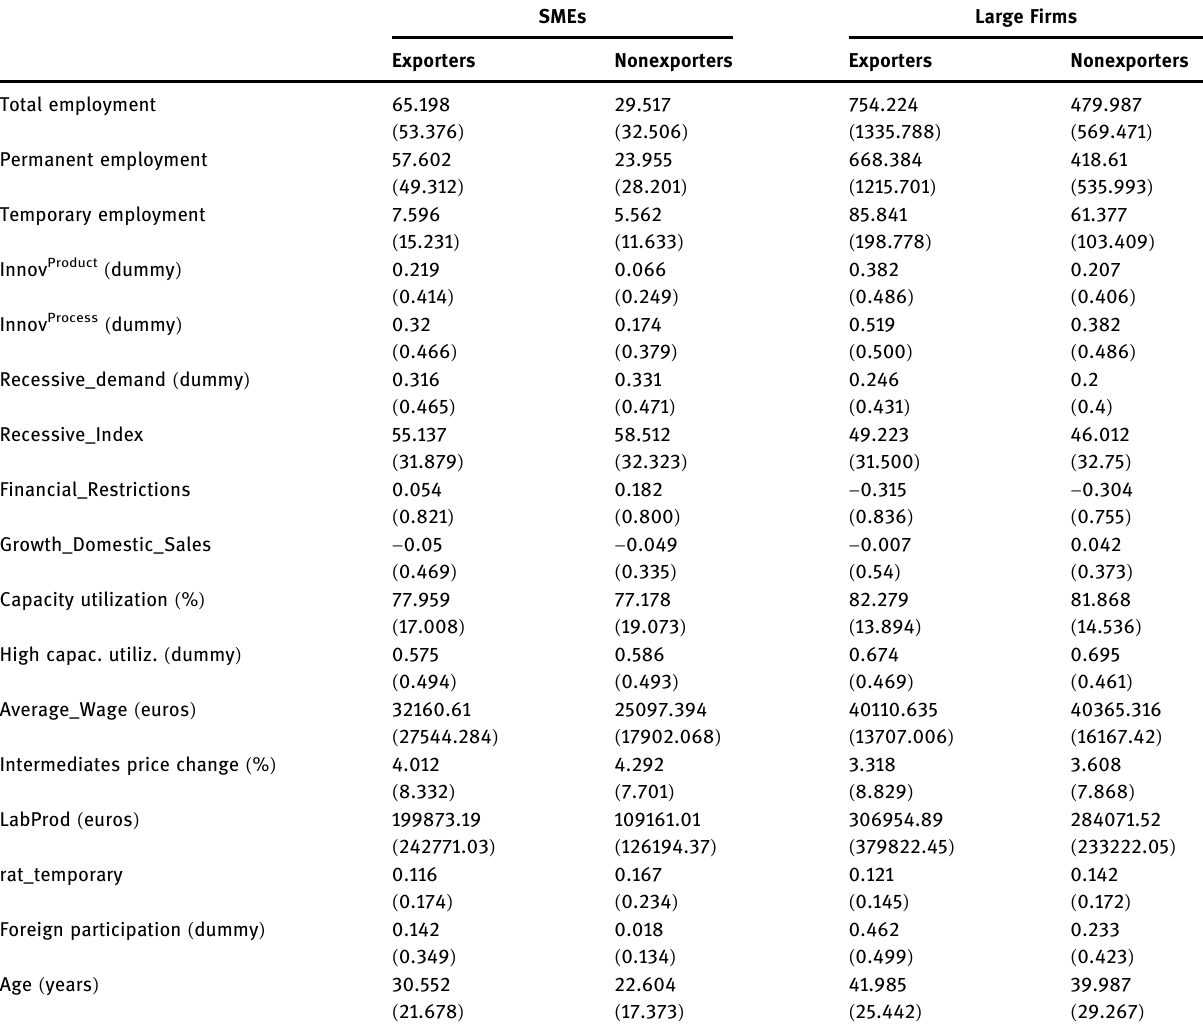
Table 1: Descriptive statistics – Average of the main variables